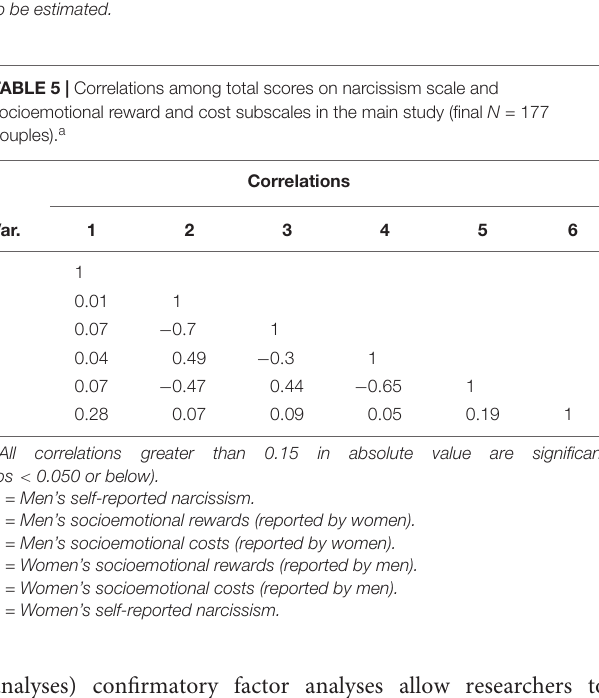
Chi-model MLDF Square P RMSEA GFI AGFI df df Men ’ s socioemotional rewards and costs (reported by women)